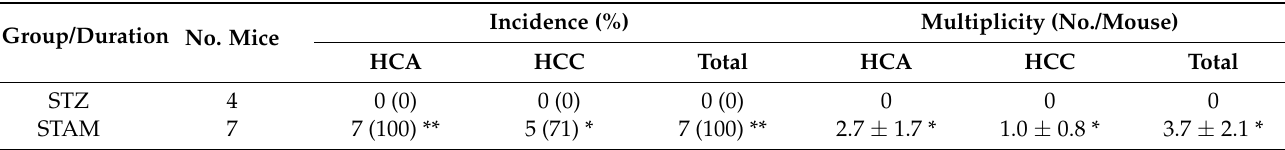
Table 1. Incidence and multiplicity of liver tumors developed in 18-week-old STAM and STZ mice. Group/Duration No. Mice